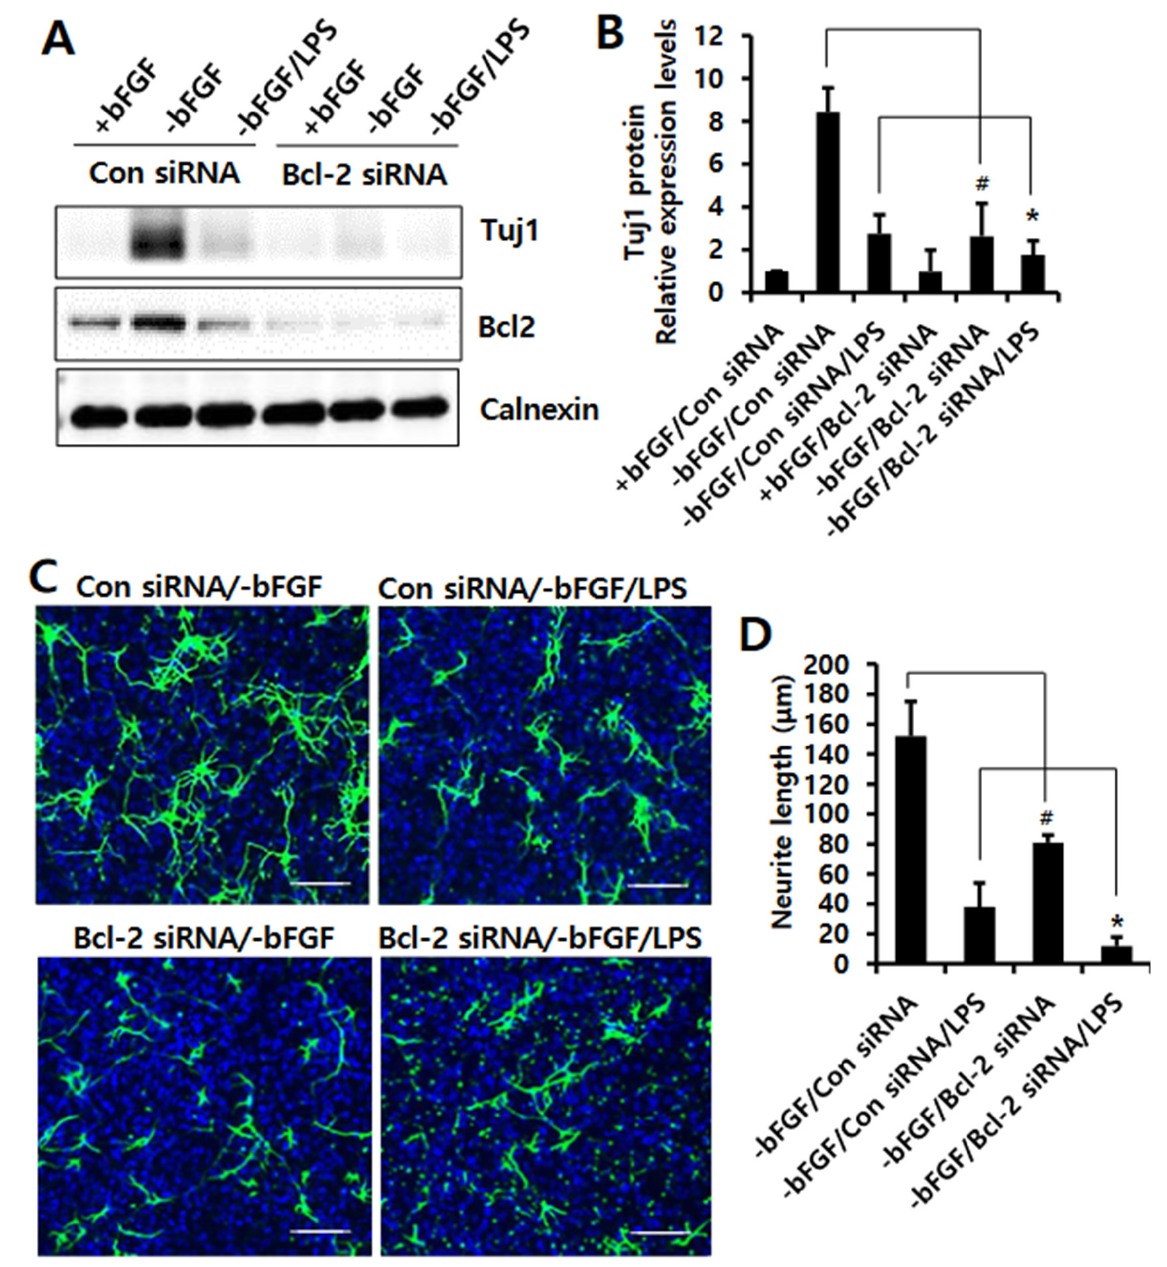
Figure 4. Effect of Bcl-2 depletion on LPS-induced neuronal damage in NSCs. ( A , B ) Control siRNA or Bcl-2 siRNA was transfected into the NSCs for 72 h, and then the cells were treated with LPS (1 µ g/mL) for 1 day in the absence of bFGF. ( A ) Western blotting was performed using anti-Tuj1, anti-Bcl-2, or anti-calnexin antibodies to detect the respective protein bands. ( B ) Band intensity was quantified with Quantity Ones ® software. Data are shown as means ± SD. * p < 0.05 compared with –bFGF/control siRNA/LPS. # p < 0.05 compared with –bFGF/control siRNA. ( C , D ) Control siRNA or Bcl-2 siRNA was transfected into the NSCs for 72 h, and then the cells were treated with LPS (1 µ g/mL) for 3 days in the absence of bFGF. The NSCs were stained with anti-Tuj1(green) and DAPI (blue). Scale bar: 100 µ m. ( D ) Neurite lengths were measured in randomly selected fields using three independent experiments; n = 3 per group. Data are shown as means ± SD. * p < 0.05 compared with –bFGF/control siRNA/LPS. # p < 0.05 compared with –bFGF/control siRNA. Statistical significances were assessed by one-way ANOVA with a post hoc Tukey’s test.